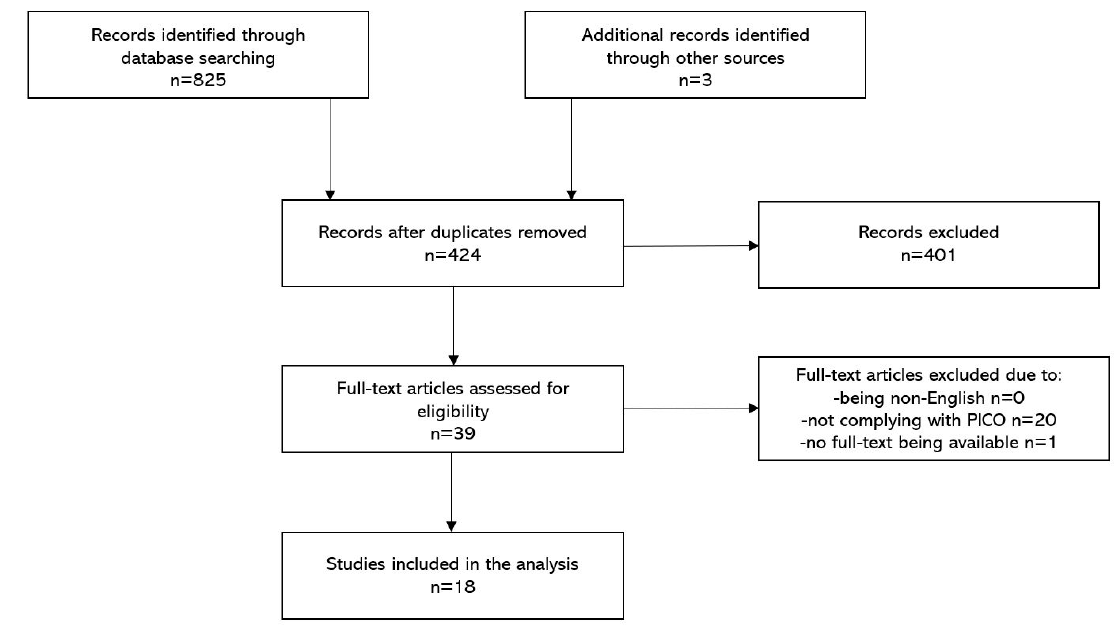
Figure 1. Structured search strategy. Table 2. Summary of the included studies.